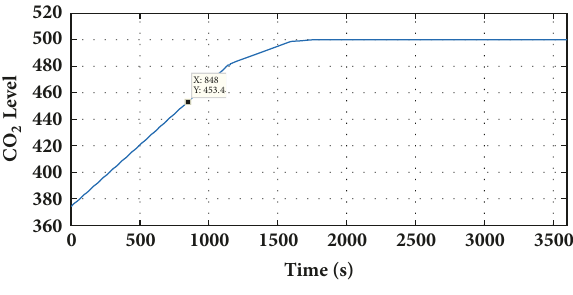
Figure 25: CO 2 level